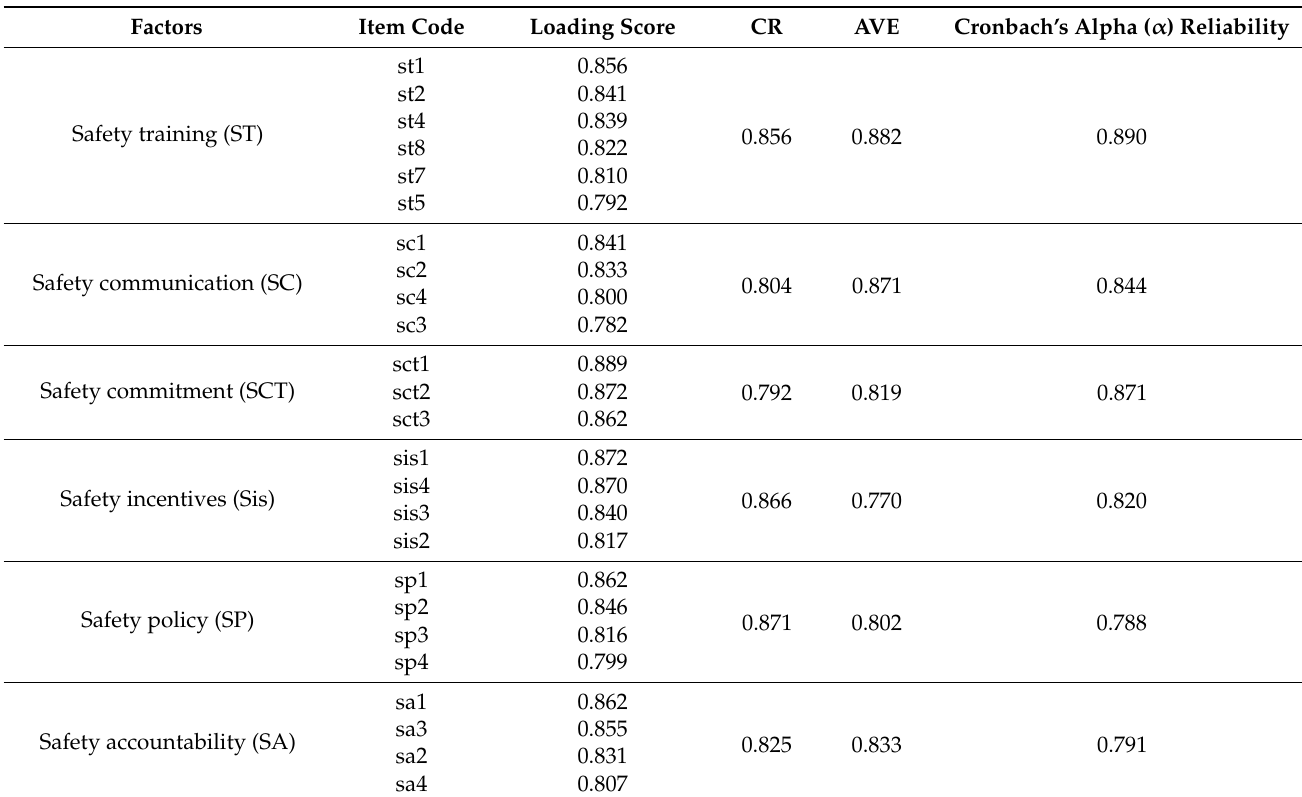
Table 4. SEM Estimations.